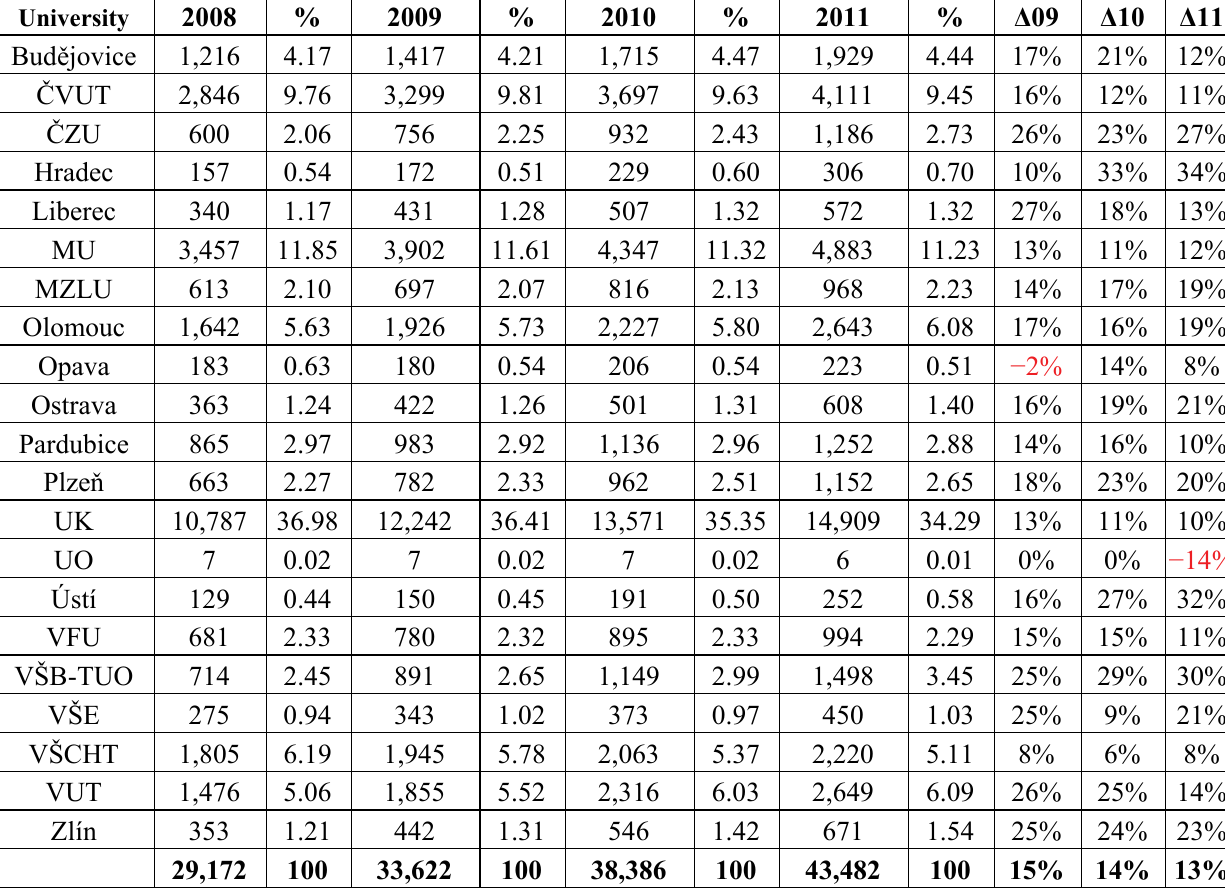
Table 5. University publication output in 2008–2011 by